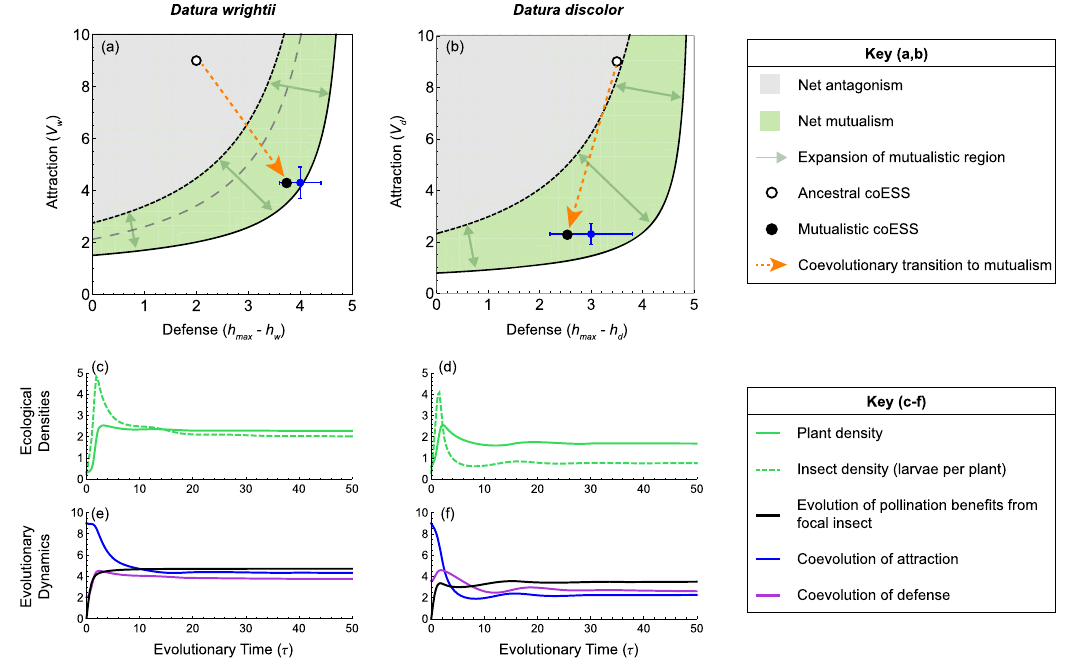
Fig. 3 Coevolution from antagonism to mutualism in the two-plant species community. Panels ( a , b ) show interaction outcomes as a function of attraction ( v i ) and defense ( h max – h i ), where h max is the maximum herbivory rate. The ancestral insect persists as a pure antagonist above the dashed gray line in panel a and is extinct below. There is no dashed gray line in panel b because the ancestral insect can persist on the ancestral D. wrightii alone. The insect persists as a net antagonist within the gray regions and is extinct within the white regions. Plant evolution of pollination bene fi ts ( b i > 0) expands the green mutualistic regions by separating the interaction breakdown boundary (solid black line) and the interaction transition boundary (dotted black line), as depicted by green arrows. Simultaneously, coevolution of attraction and defense drives the transition to net mutualism, as depicted by orange arrows from ancestral coESS (white points) to the new coESS (black points). Blue points give empirical estimates of the coESS (panel ( a ): h w = 1 ± 0.4; v w = 4.3 ± 0.6; panel ( b ): h d = 2 ± 0.8; v d = 2.3 ± 0.4), where the crossbars show variation in leaf consumption 30 and the standard error of fl oral visitation 19 ( n = 89 plants for D. wrightii ; n = 33 plants for D. discolor ) (Methods). While the plant species coevolve in the model (see Supplementary Movie 3), panels ( a , b ) are plotted with the other plant species held at its fi nal coESS for clarity. Panels ( c , d ) plot the equilibrium densities of each Datura species (solid green lines) and insect larvae per plant of each Datura species (dashed green lines) over evolutionary time, τ . Panels ( e , f ) plot the coevolutionary dynamics of pollination bene fi ts ( b i ; black lines), attraction ( v i ; blue lines) and defense ( h i ; purple